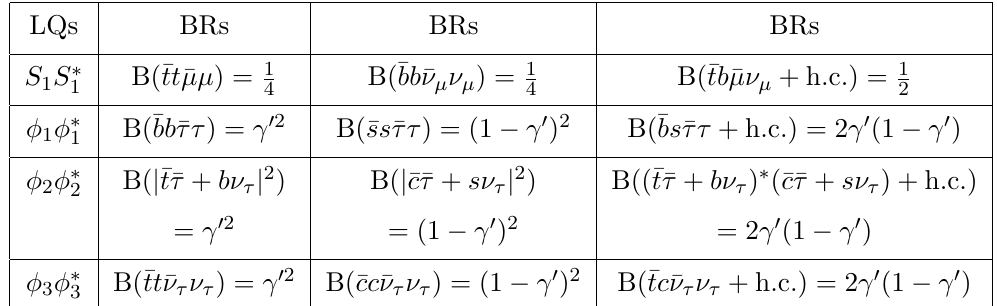
Table 3 . Branching ratios of products of DM annihilations into leptoquarks, for the dominance of the extra couplings, (cid:21) 32 , (cid:20) 23 and (cid:20) 33 . Here, (cid:13) 0 (cid:17) (cid:20) 2